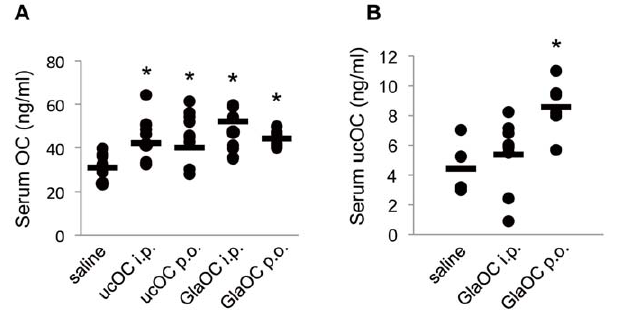
Figure 5. Serum levels of total OC and ucOC after intraperito- neal or oral administration of ucOC or GlaOC. Serum levels of total OC ( A ) or ucOC ( B ) were measured 20 min after administration of ucOC or GlaOC at a dose of 7 m g/kg intraperitoneally (i.p.) or 10 m g/kg orally (p.o.) in mice that had been deprived of food for 5 h; black circles indicate values for individual mice, with the horizontal bars represent- ing the mean values. * P , 0.05 versus saline-treated animals [one-way ANOVA followed by either Dunnett’s multiple-comparison test ( A ) or Tukey’s HSD post hoc test ( B )].